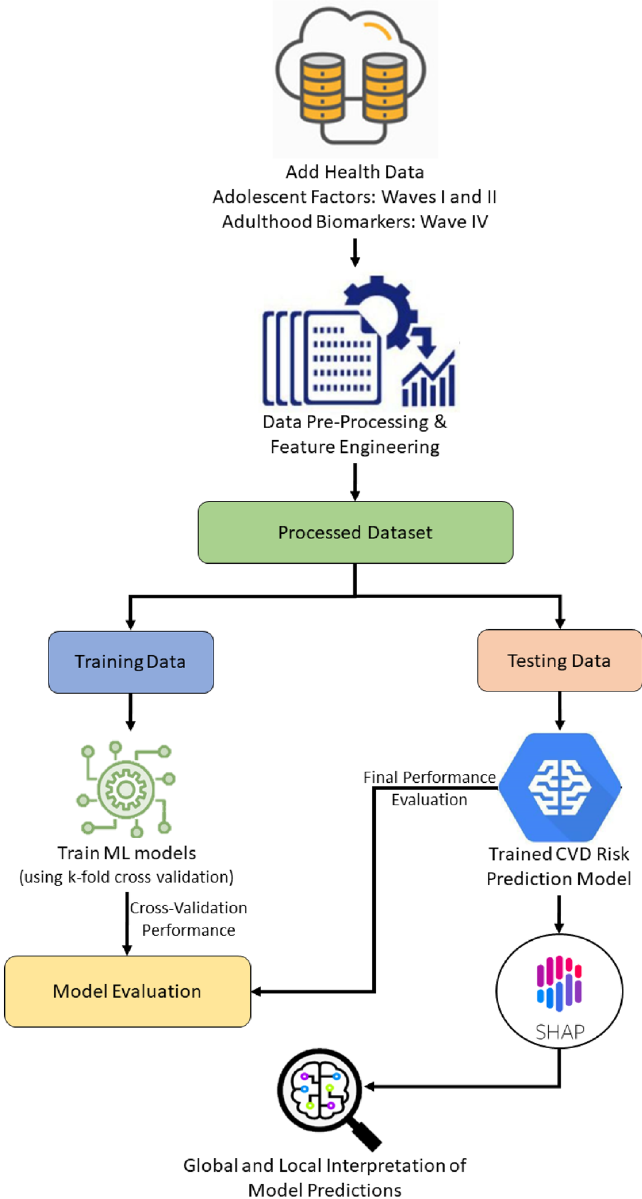
Figure 1. Overview of explainable machine learning framework for CVD risk